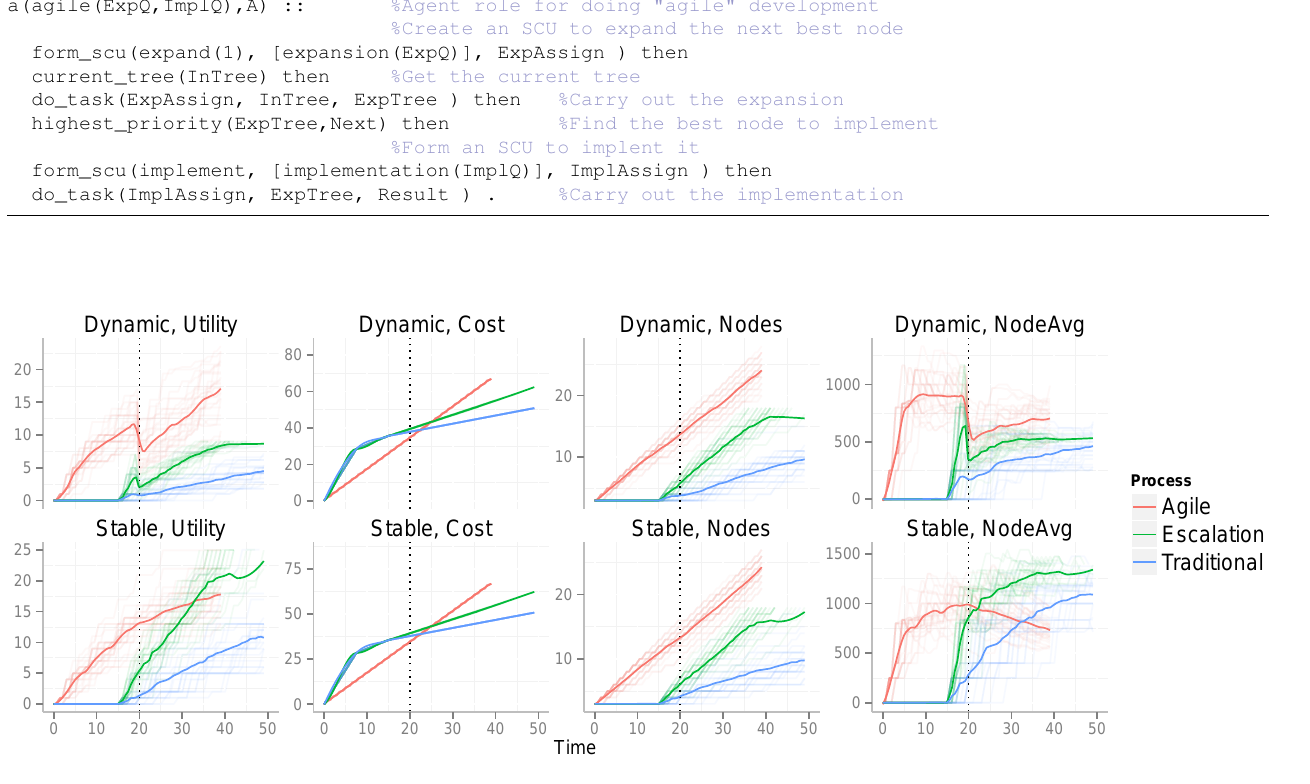
Figure 7. Simulation outcomes for the two scenarios and three workflows. Faint lines represent individual runs ( n = 30 in each condition), and solid lines are smoothed ensemble averages. Utility is the average utility of the feature tree across the population; Cost is the financial cost of developing the community-software; Nodes is the number of features (nodes) implemented; and NodeAvg is the average utility provided by each feature (an indication of the quality of community fit). The dotted vertical lines indicate the time where the Dynamic scenario undergoes a step change in the population